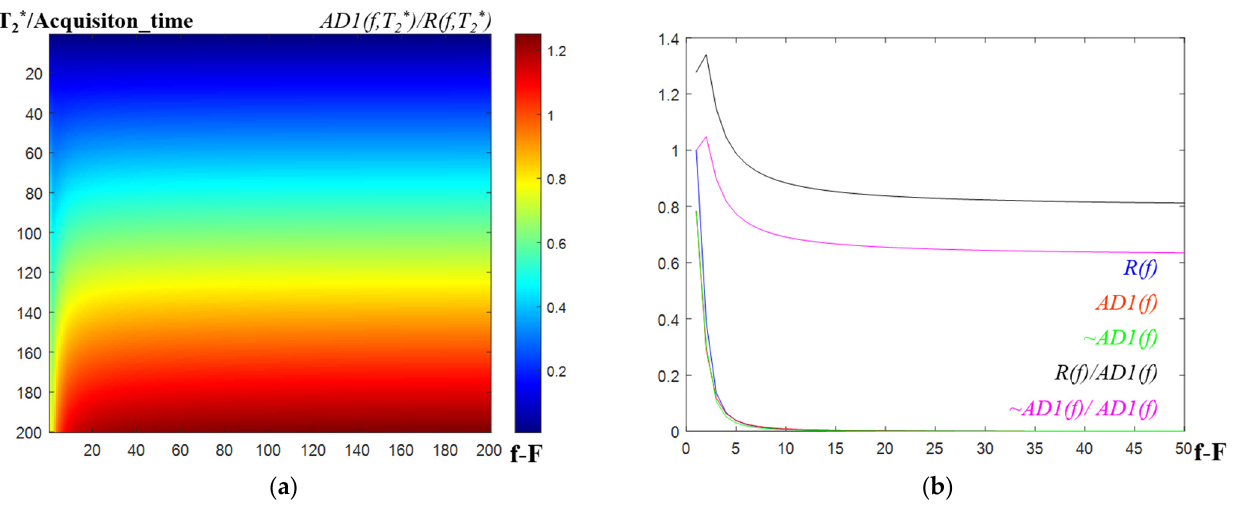
Figure 2. Picture showing that the differential filtering does not distort the shape of the original spectral signal graph ( R ( f )) when the differential operator is [-1,1]. ( a ) The ratio map (according to the T 2* and f) between the DFAV and UFRV ( AD1 ( f, T 2* )/ R ( f, T 2* )). ( b ) Graph of the normalized UFRV (blue), DFAV (red), approximated_DFAV (green). UFRV/DFAV with the black line, and approximated_DFAV/DFAV with the magenta line, when T 2* / acquisition_time is 200. DFAV, differential filtered absolute value; UFRV, un-filtered real value.